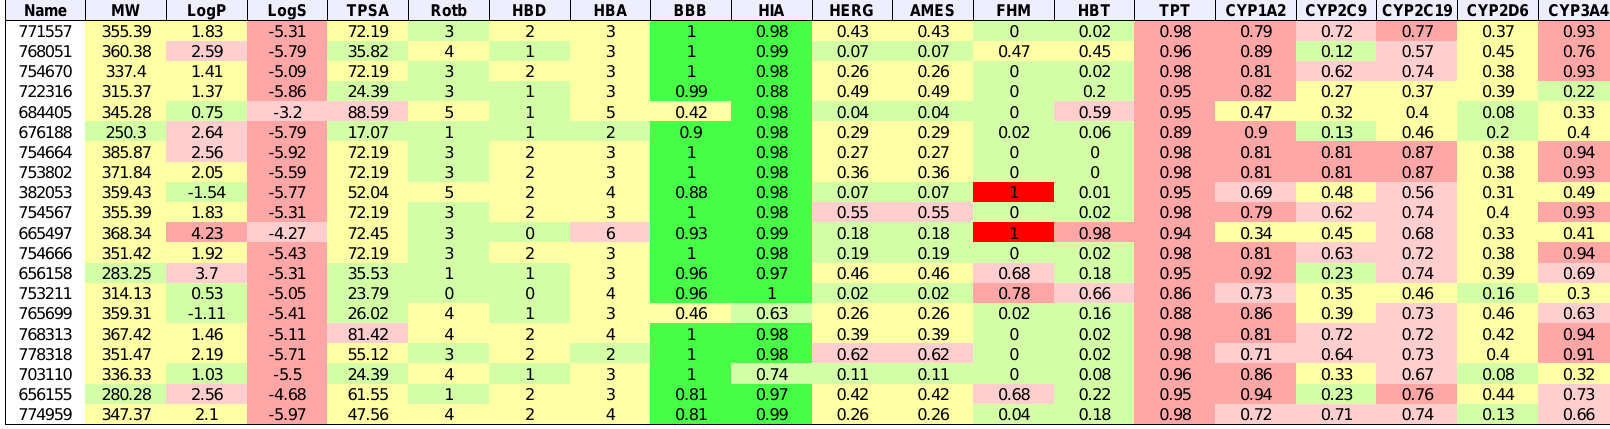
Table 6. Colon cancer: List of physio-chemical properties and predicted toxicology and ADME for top 20 ligands. Toxicology and ADME predictions are probabilities in the range [0, 1] *.